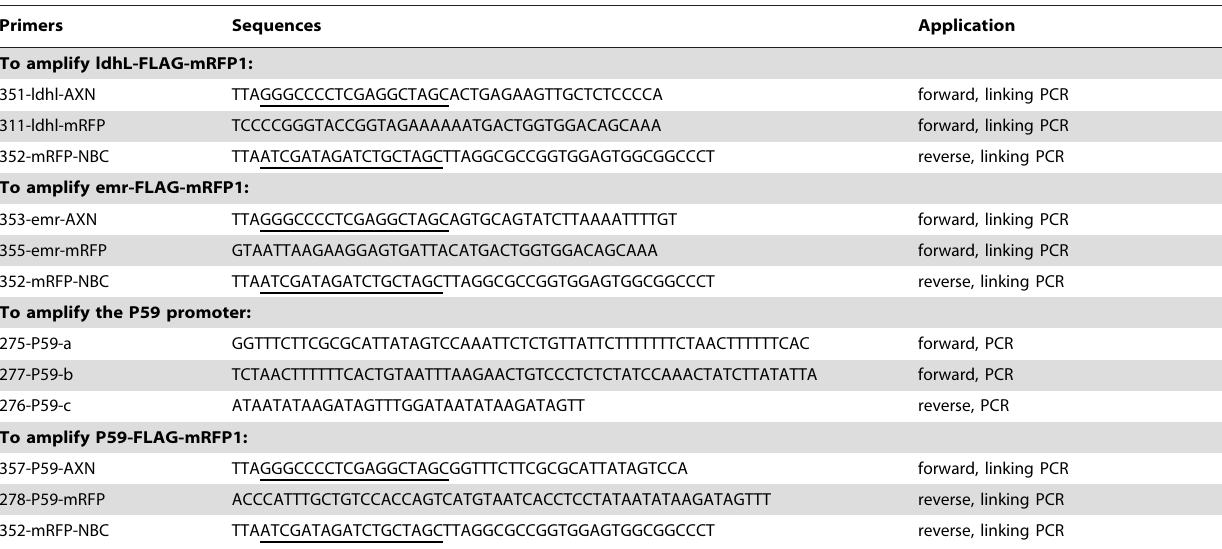
Table 2. Primers used in this